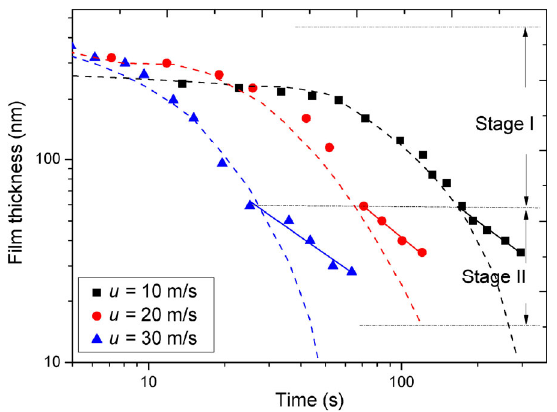
Fig. 8 Measurements of starved central film thickness against time after the oil supply is suspended for a range of speeds, pure rolling, p H = 431 MPa, t 0 = 25 ° C,